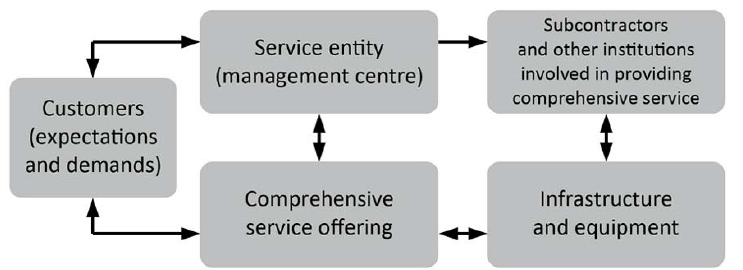
Figure 2. The method of providing comprehensive services in a transshipment terminal. Source: own elaboration, based on [26].